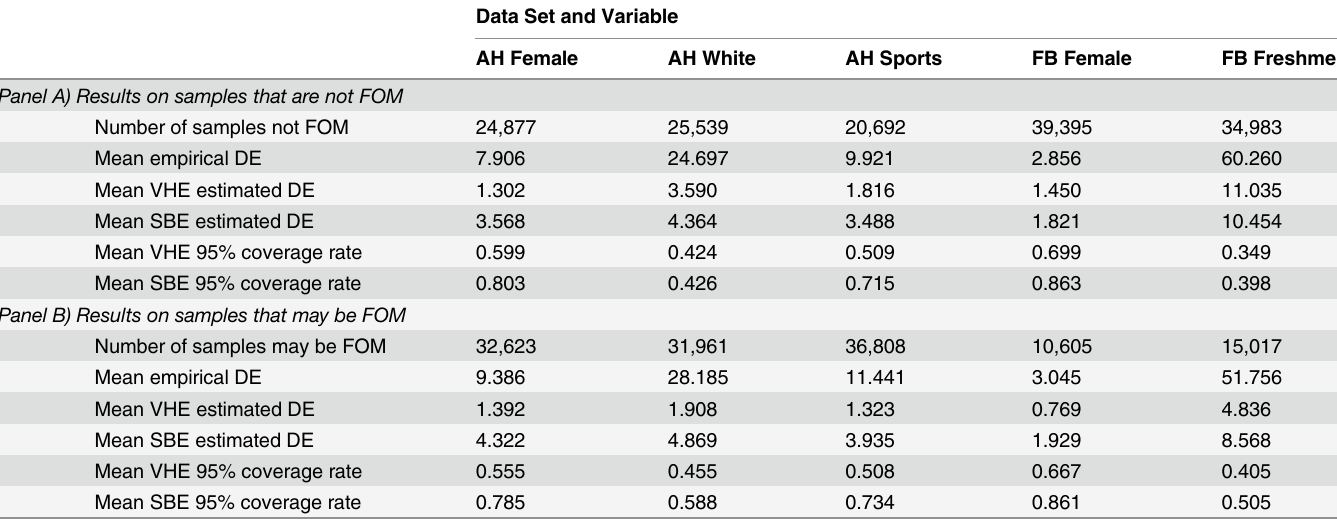
Table 4. Comparison of Design Effects, Estimated Design Effects, and Coverage Rates across samples that are not FOM or may be FOM, by data set and variable.